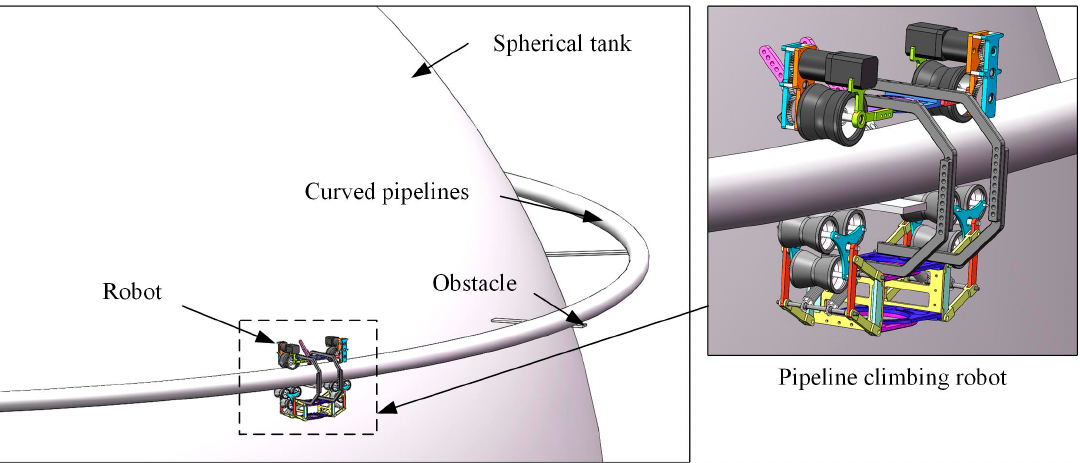
Table 1. Parameters of the pipeline-climbing robot. Figure 5. Schematic diagram of the robot climbing on curved pipelines of spherical tanks.